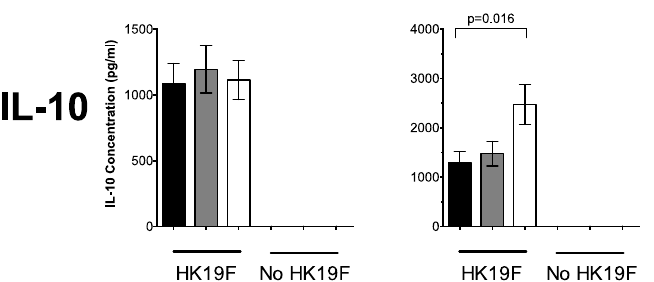
Figure 1. Cytokine responses of HK19F ‐ stimulated PBMCs and CD14+ monocytes. HK19F (1:50 ratio) stimulated PBMCs and CD14+ monocytes pre ‐ treated with 1,25(OH) 2 D 3 or 25(OH)D 3 for 4 h. Cytokine concentrations (pg/mL) were measured in PBMC and CD14+ monocyte supernatants by multiplex assay. Data shown represents Mean ± SEM for PBMCs ( n = 13) and CD14+ monocytes ( n = 7), respectively. Significance was calculated using a paired Wilcoxon sign ‐ rank test (black bar = untreated, grey bar = 25(OH)D 3 and white bar = 1,25(OH) 2 D 3 ). For PBMCs stimulated with LPS, TNF ‐α was significantly reduced by 3.6 ‐ fold and three ‐ fold by 1,25(OH) 2 D 3 and 25(OH)D 3 , respectively ( p = 0.0002; Figure 2). The IFN ‐γ concentrations were also significantly reduced in PBMCs treated with 25(OH)D 3 (9 ‐ fold, p = 0.0002) and 1,25(OH) 2 D 3 (five ‐ fold, p = 0.0002) compared to untreated PBMCs. PBMCs treated with 25(OH)D 3 significantly reduced IL ‐ 1 β (1.3 ‐ fold; p = 0.04), whereas PBMCs treated with 1,25(OH) 2 D 3 significantly reduced IL ‐ 10 (1.2 ‐ fold, p = 0.017) and IL ‐ 8 (1.5 ‐ fold; p = 0.001). In LPS ‐ stimulated CD14+ monocytes, 1,25(OH) 2 D 3 significantly reduced TNF ‐α by 6.2 ‐ fold ( p = 0.016) compared to untreated monocytes. The CD14+ monocytes treated with 25(OH)D 3 significantly reduced IL ‐ 1 β by 2.7 ‐ fold ( p = 0.031), but not for 1,25(OH) 2 D 3 . There was no differential effect of 1,25(OH) 2 D 3 or 25(OH)D 3 when we compared the responses after stratification by gender or age (data not shown), although the numbers of individuals for each